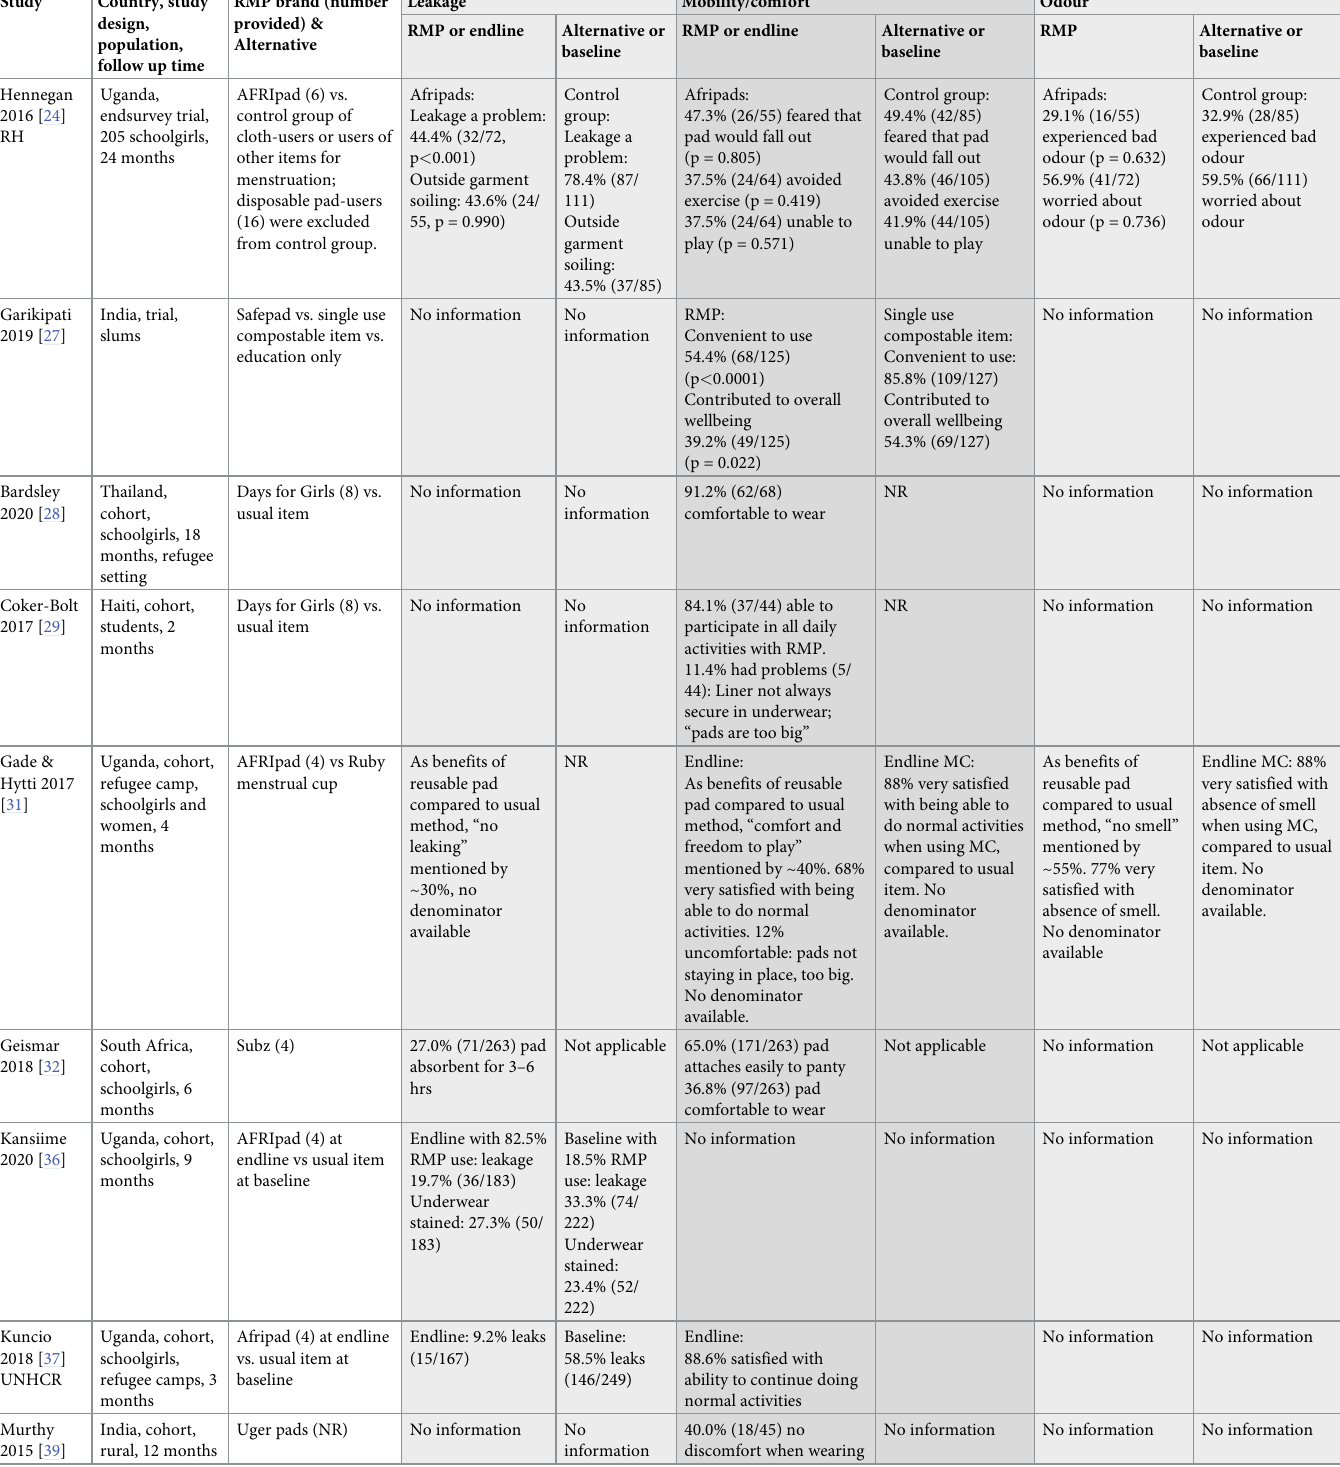
Table 3. Information on leaking, mobility and odour when using reusable menstrual pad. Study Country, study